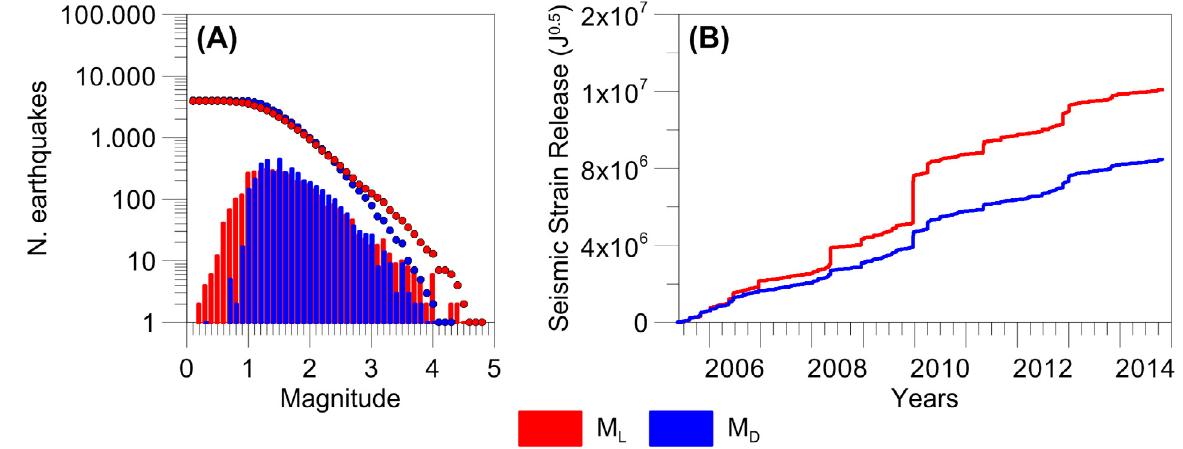
Figure 4. (A) Frequency magnitude distributions, in normal and cumulative scale, and (B) cumulative seismic strain release calculated using the Richter [1958] relationship for the earthquakes used in this study. Blue for M